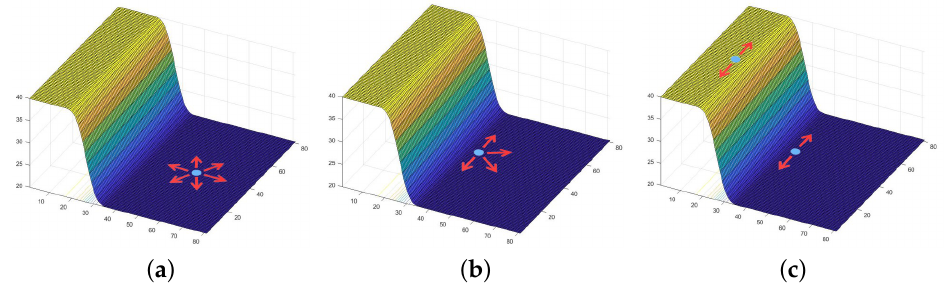
Figure 1. Region orientation characteristics and practical usage orientation: ( a ) Homogeneous region characteristics, ( b ) edge region characteristic, ( c ) practical usage smooth direction.